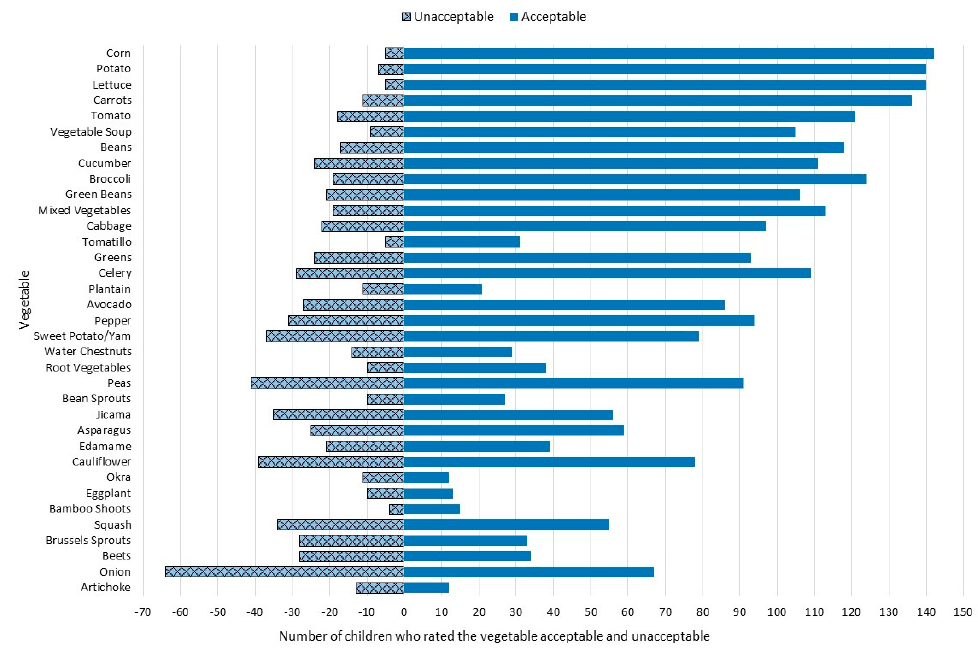
Figure 2. Number of children (out of 149) that found each vegetable acceptable and unacceptable. Acceptable was a rating ≥ 5; unacceptable was a rating <5. The vegetables are listed in order of descending mean liking ratings.